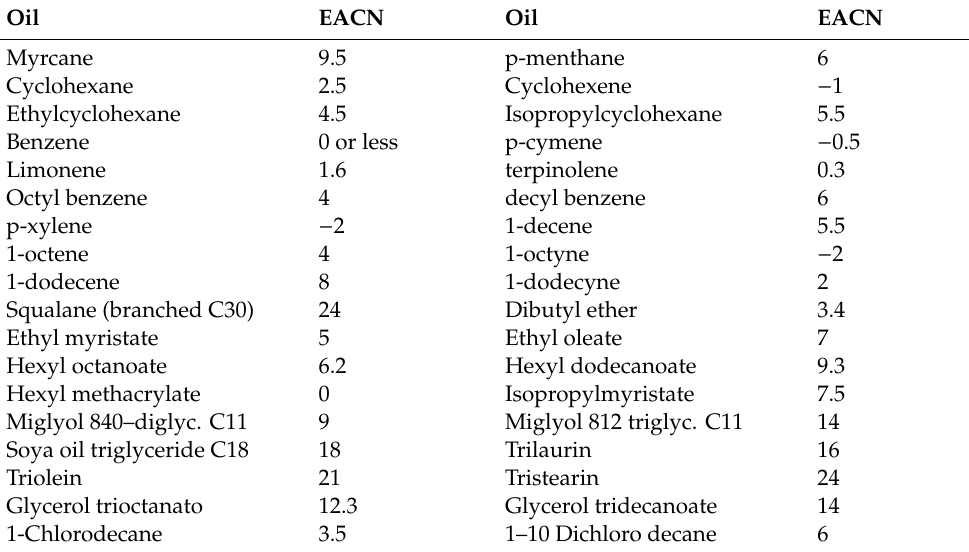
Table 2. Equivalent oil alkane carbon number (EACN) values for oils with branching, cycles, double and triple